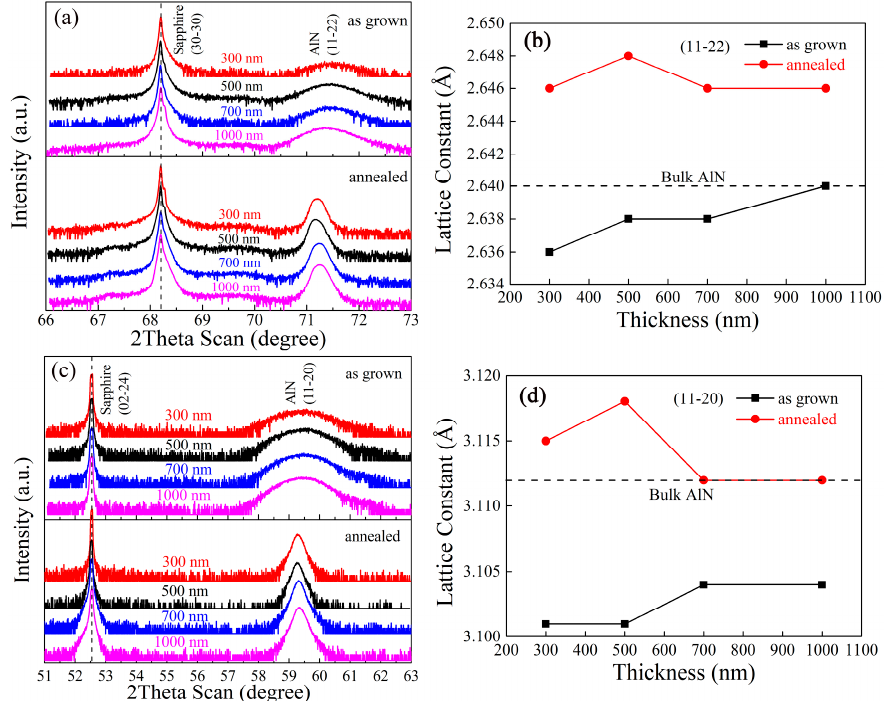
Figure 3. ( a , c ) The 2theta-Omega scans along different crystalline directions of as-grown and 5 h-annealed samples with various thicknesses; the lattice constants of ( b ) (11–22) and ( d ) (11-20) planes calculated from the 2Theta-Omega curves as a dependence of